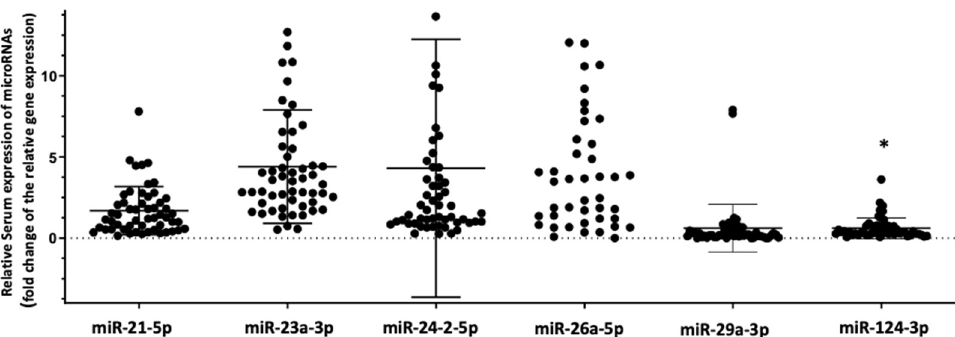
Figure 2. Relative serum expression of the tested miRNAs in HIV+ compared to HIV − individuals. Values are expressed as gene fold changes only in HIV+ individuals *: p values < 0.05.